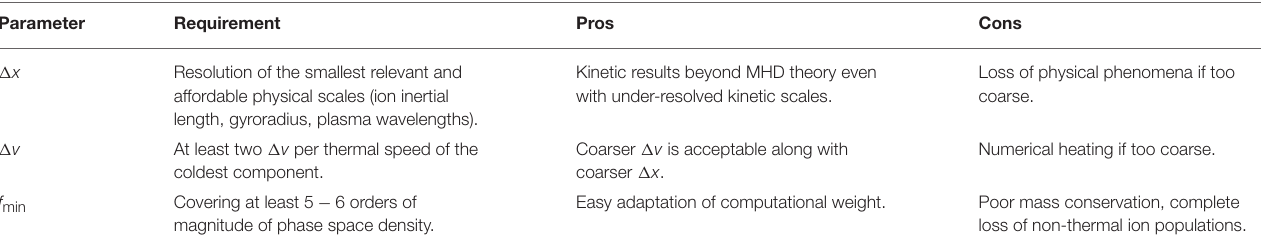
TABLE 4 | Minimum requirements for 1 x , 1 v , and f min along with related major advantages and disadvantages in hybrid-Vlasov simulations with Vlasiator.